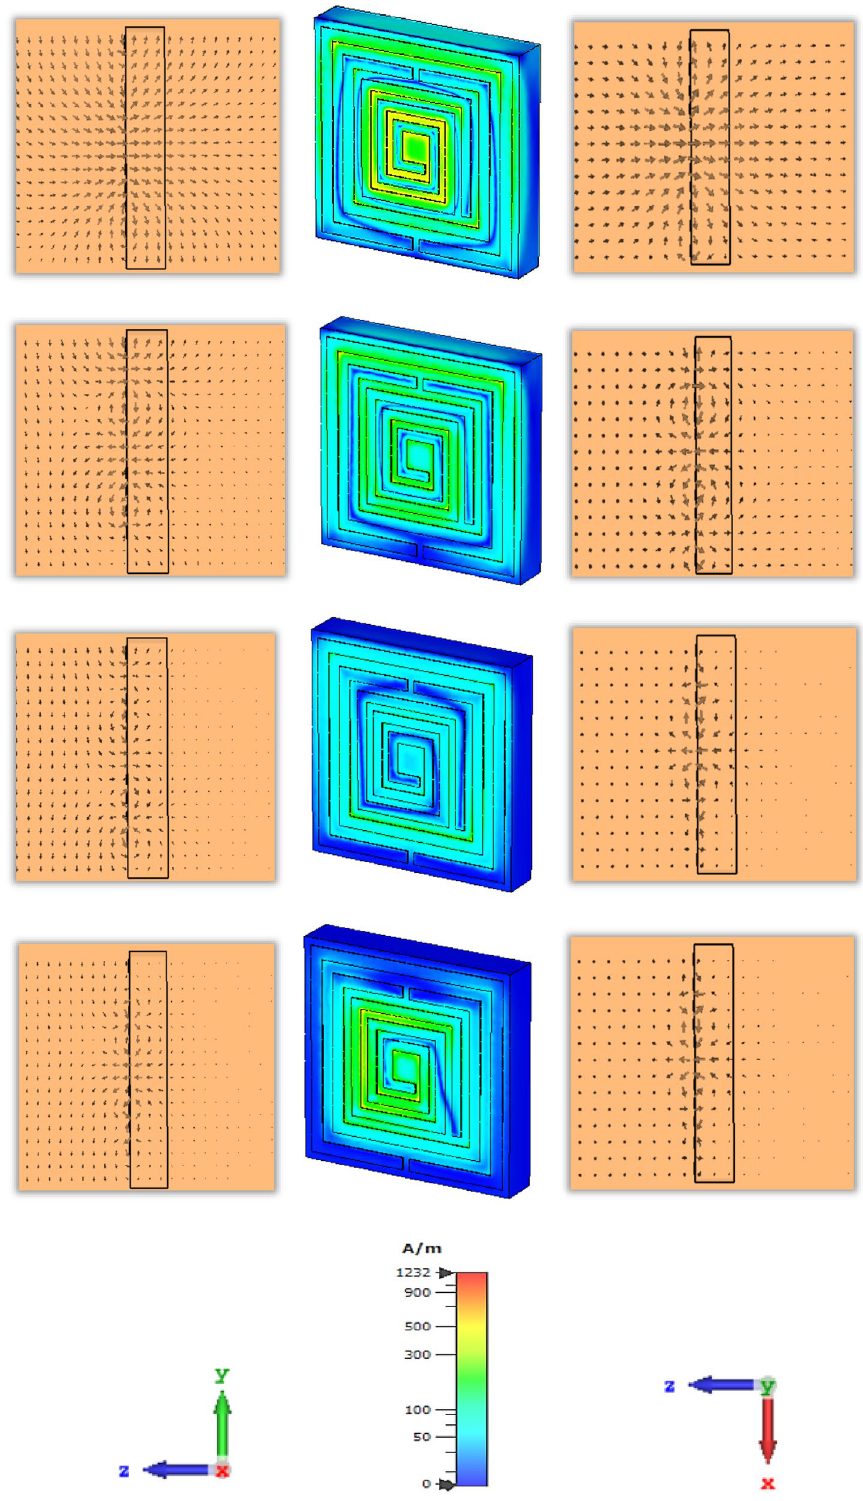
Figure 8. Magnetic field distribution in row-wise ascending from the top order for different resonant frequencies of 1.87, 2.55, 4.32, 5.46 GHz